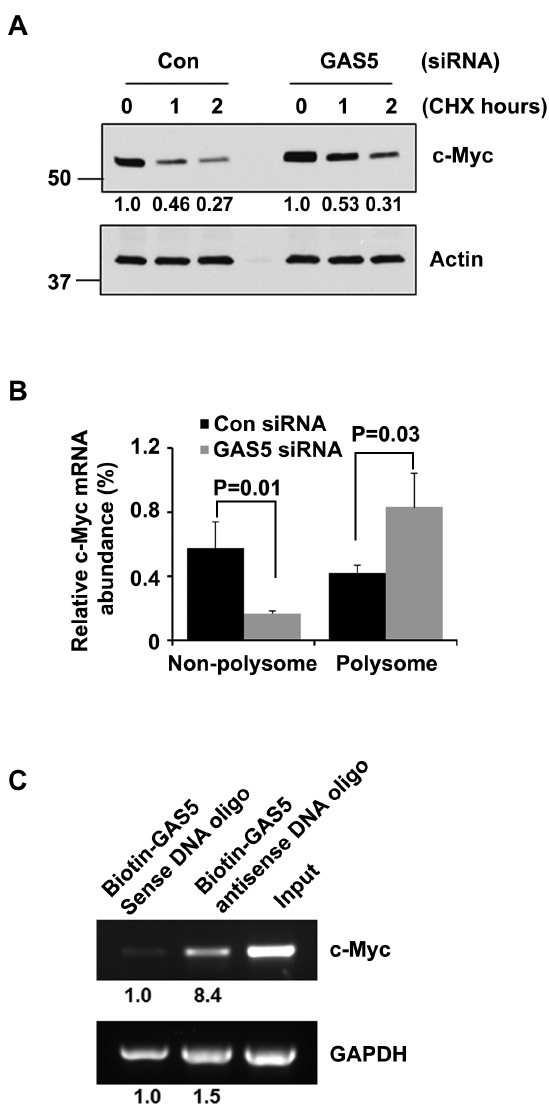
Figure 4. GAS5 suppresses c-Myc translation through direct binding with its mRNA. ( A ) The protein level of c-Myc was assessed